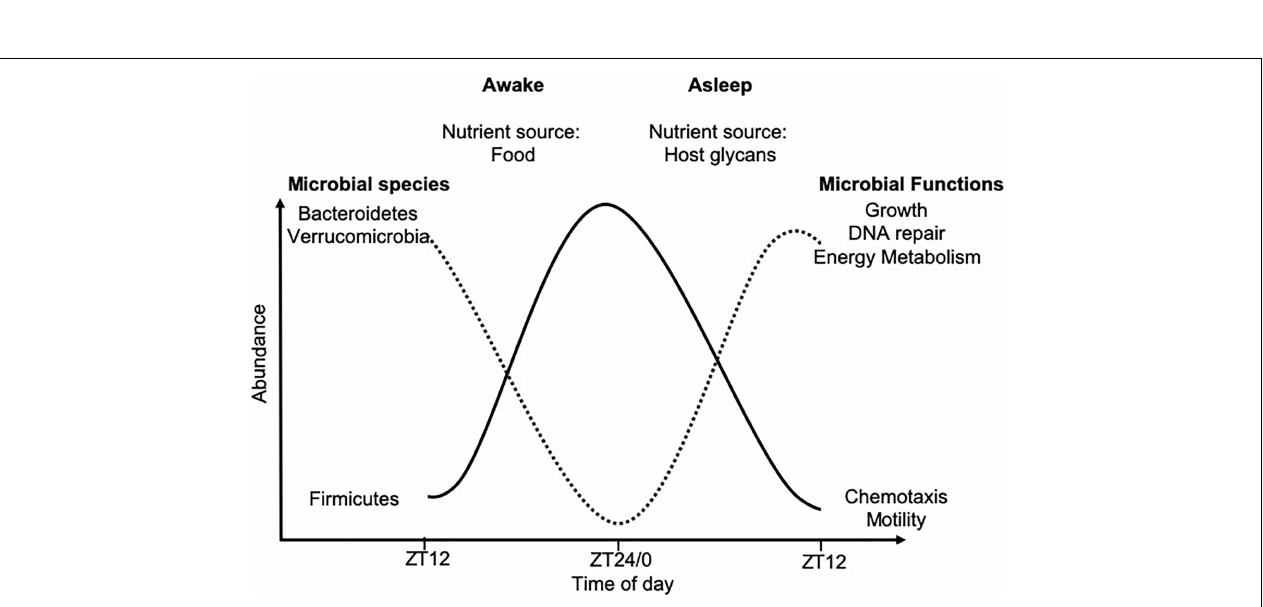
FIGURE 2 | Time-of-day-dependent commensal microbial changes. Oscillations in microbial abundance and functions change at different times-of-day. The abundance of species belonging to the Firmicutes phylum (solid black line) increase in response to dietary intake, while species of the Bacteroidetes and Verrucomicrobia phyla (dotted black line) increase in abundance once all the nutrients from the food have been metabolized, due to their ability to metabolize host glycans. These data were compiled from animal studies with data shown over a 24-h period from ZT12 on 1 day, to ZT12 the following day. ZT12 refers to 12 h post light onset, while ZT24/0 refers to the end of the dark period and the start of the light cycle in standard 12-h light/dark housing conditions, with mice fed ad libitum .